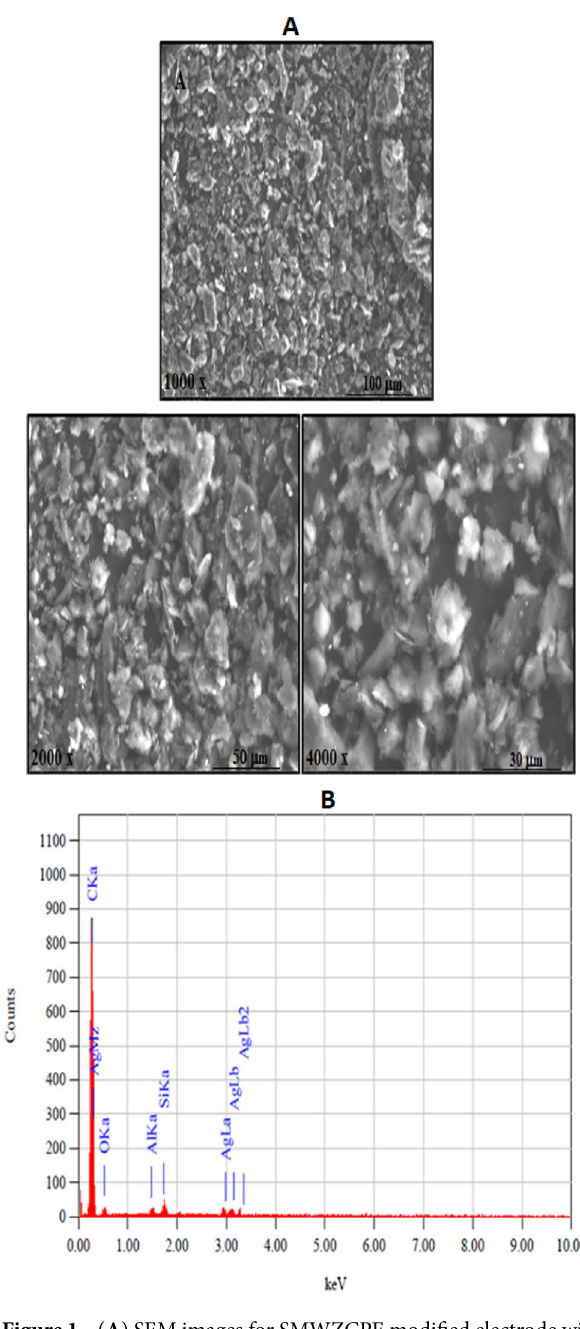
Figure 1. ( A ) SEM images for SMWZCPE modified electrode with different magnifications. ( B ) EDX analysis for SMWZCPE modified